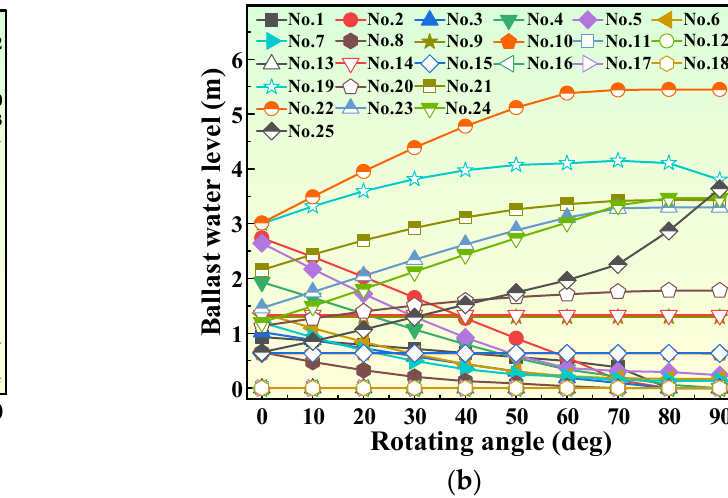
Figure 22. Allocation schemes solved by different algorithms. ( a ) PSO algorithm. ( b ) FPSO